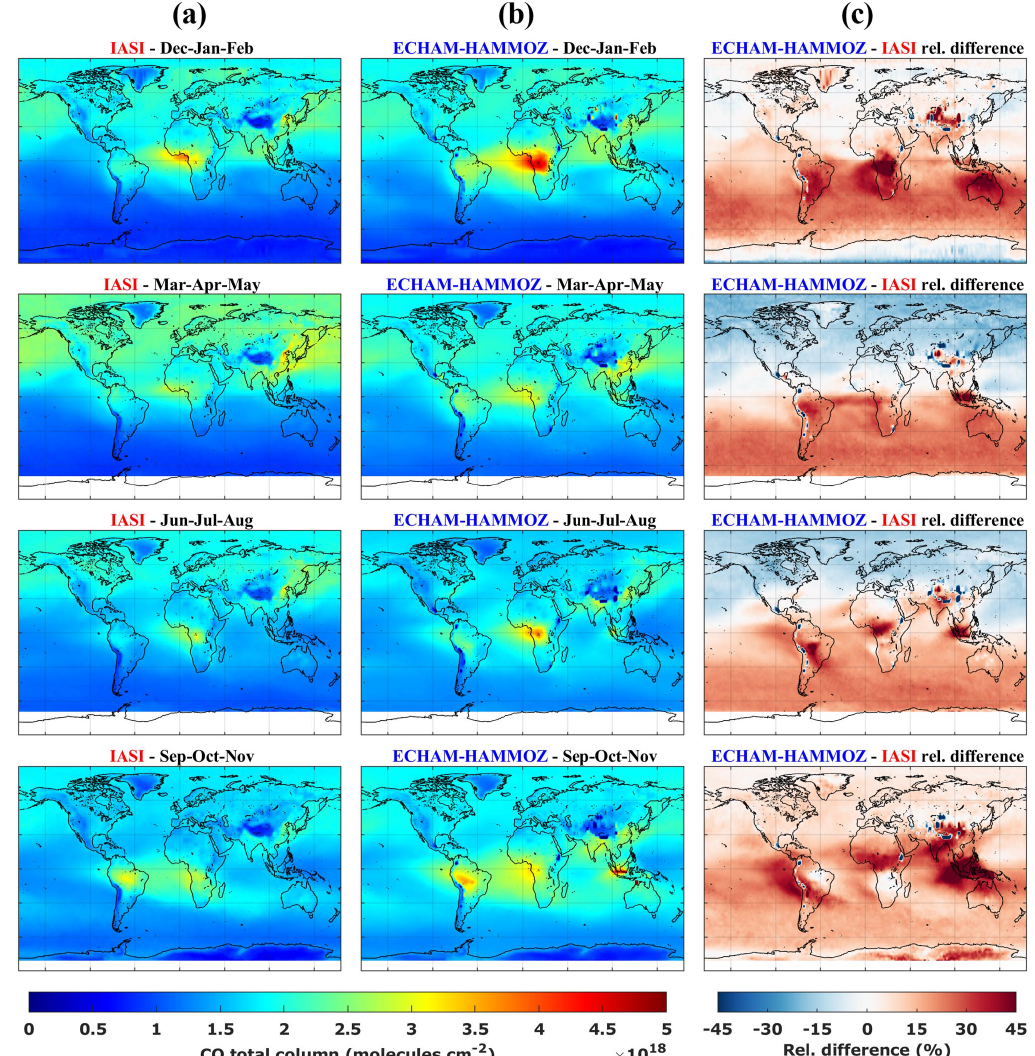
Figure 10. (a, b) Comparison of seasonal mean total column CO (in 10 18 cm − 2 ) by ECHAM-HAMMOZ with data from the IASI instrument. Data and model results are from 2008. IASI data were interpolated onto the model grid and averaging kernels were applied to the model data. (c) CO total column relative differences (in %) between ECHAM-HAMMOZ and